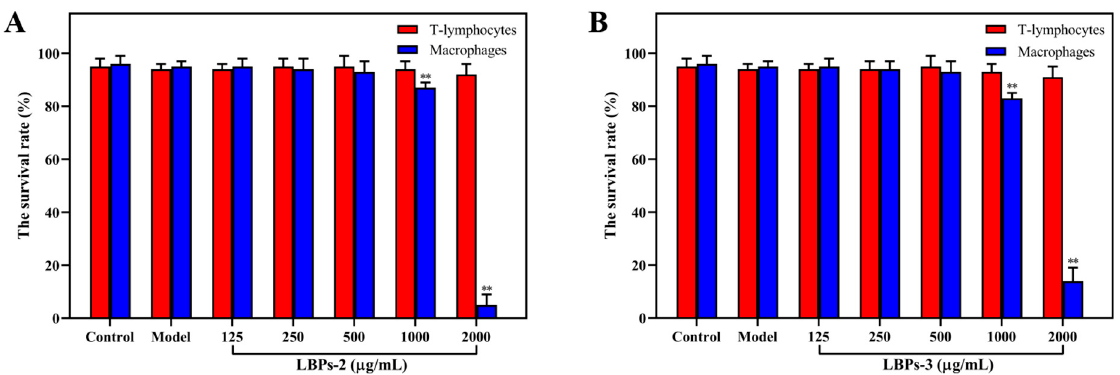
Figure 8. The survival rate of zebrafish treated by LBPs-2 and LBPs-3 with different concentrations. All data are presented as the mean ± SD (n = 30); * and ** indicate statistically significance differences at p < 0.05 and p < 0.01 compared to the control group, respectively.